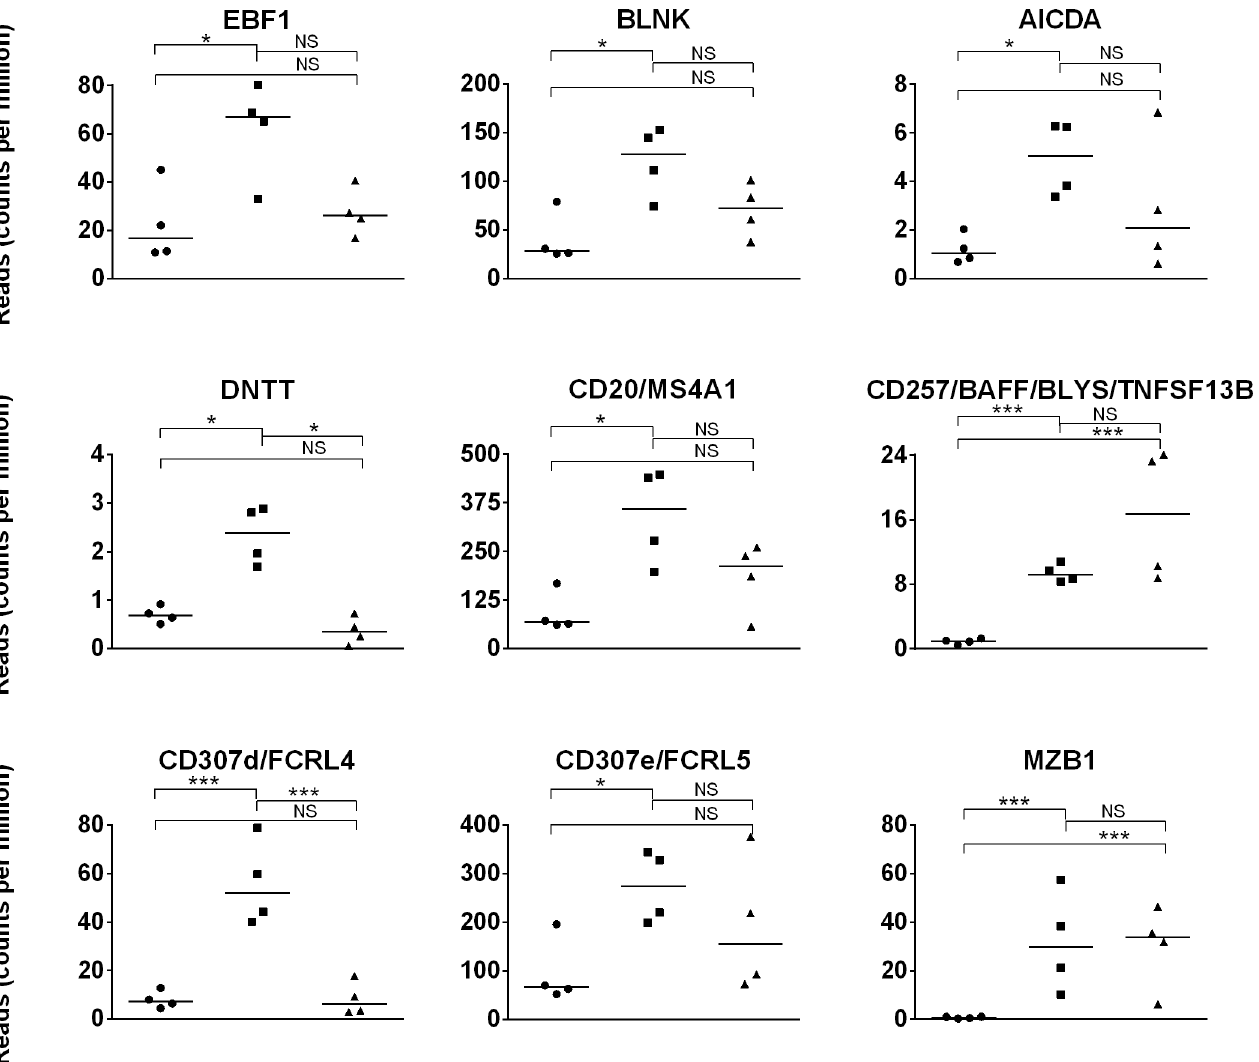
Fig 4. B cell gene expression in day 1 foal, day 42 foal, and adult horse samples. Expression (quantified by number of reads on y-axis) of B lineage genes on day 1 foal (circle), day 42 foal (square), and adult (triangle) samples are plotted on the x-axis. The significance level of comparisons is indicated by asterisks (